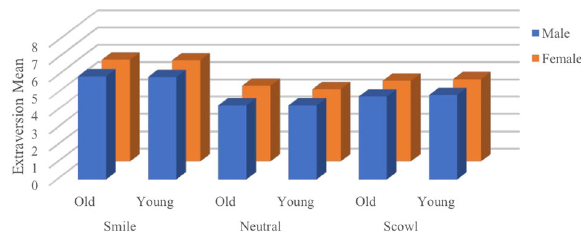
Fig. 12 Facial expression and Extraversion. This graph presents interaction of facial expression, age, and gender on mean ratings of Extraversion.